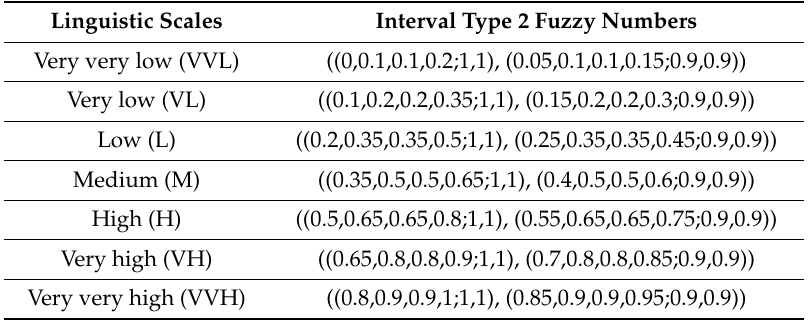
Table 2. Linguistic Scales and fuzzy numbers for the Criteria.